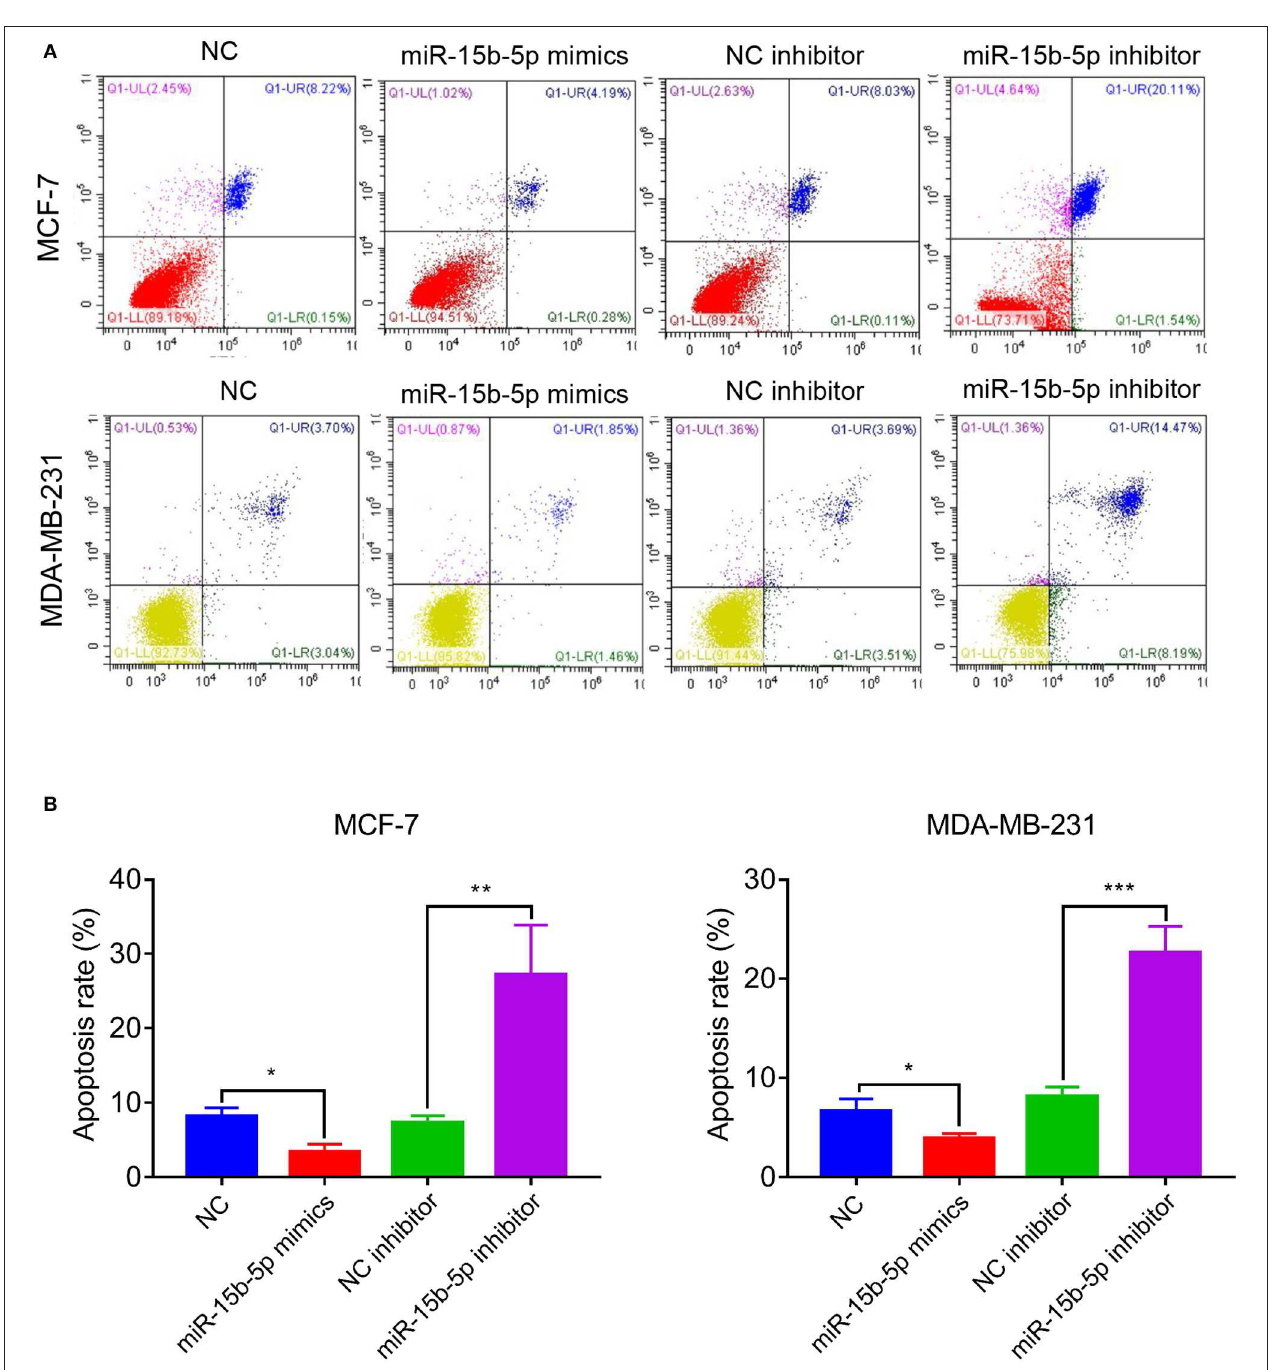
FIGURE 4 | miR-15b-5p knockdown induced cell apoptosis of breast cancer cell lines. (A,B) Flow cytometry showed that the apoptotic rates of breast cancer cells were significantly increased following the miR-15b-5p inhibitor when compared with the inhibitor NC (* P < 0.05, ** P < 0.01 and *** P < 0.001).